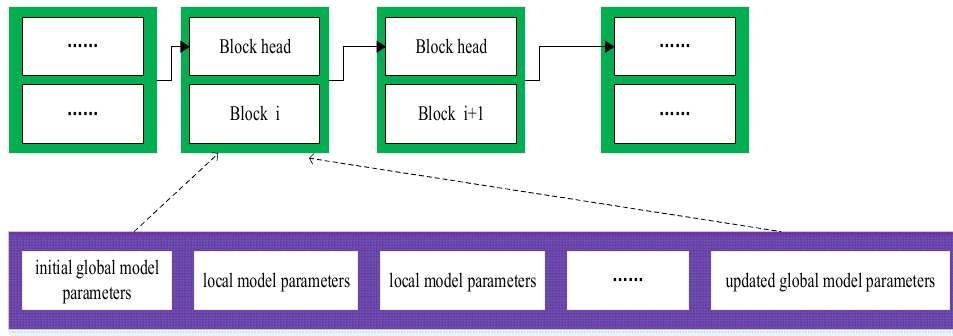
Figure 2. Block storage